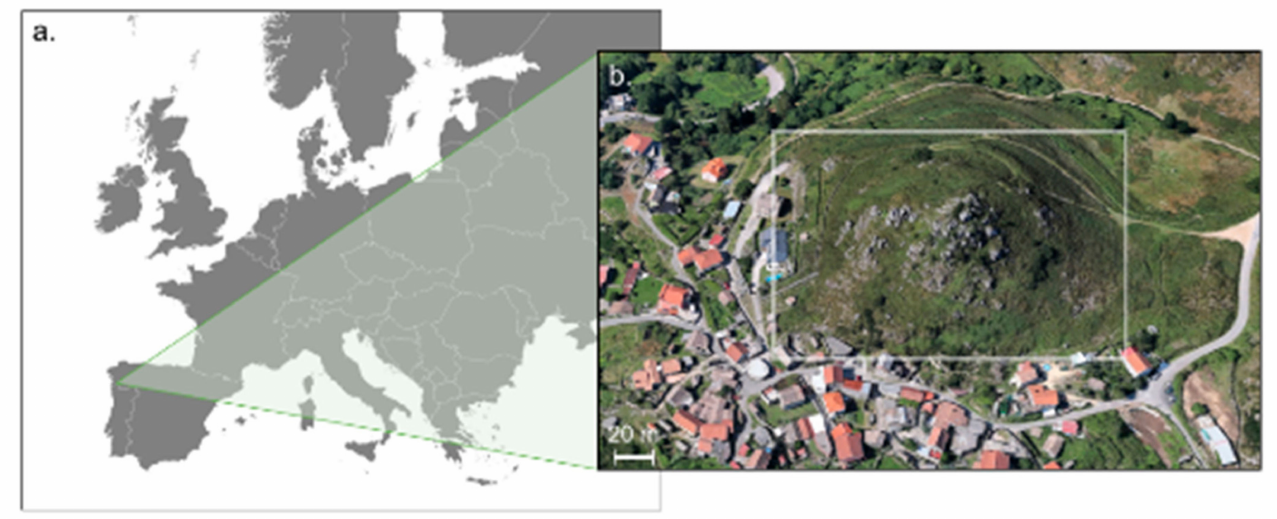
Figure 7. ( a ) Location of the area of study (Chandebrito, NW Spain); ( b ) aerial view of the village and hill (indicated by a white contour) from © Google